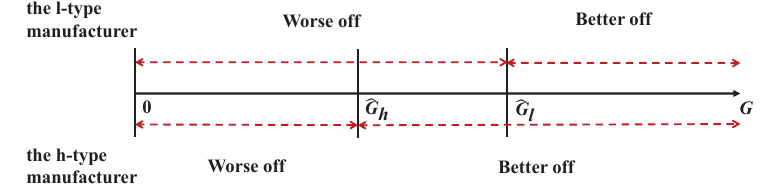
Figure 2. Illustration of Performance